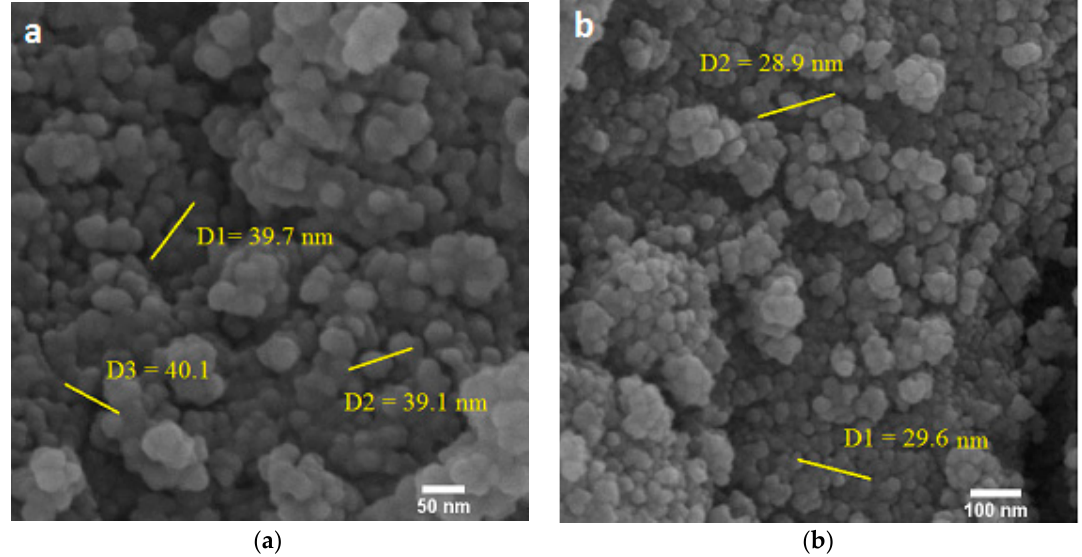
Figure 4. FE-SEM images of ( a ) bare Fe 3 O 4 NPs, and ( b ) Fe 3 O 4 @Tre NPs.